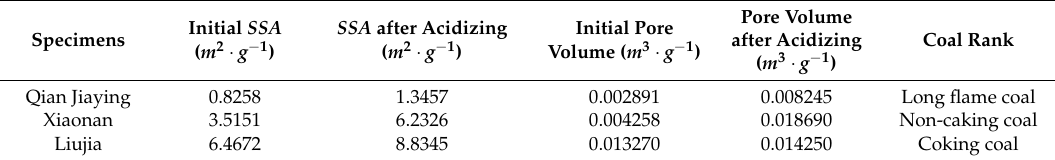
Table 2. SSA and Pore Volume of Specimens by Acidizing.